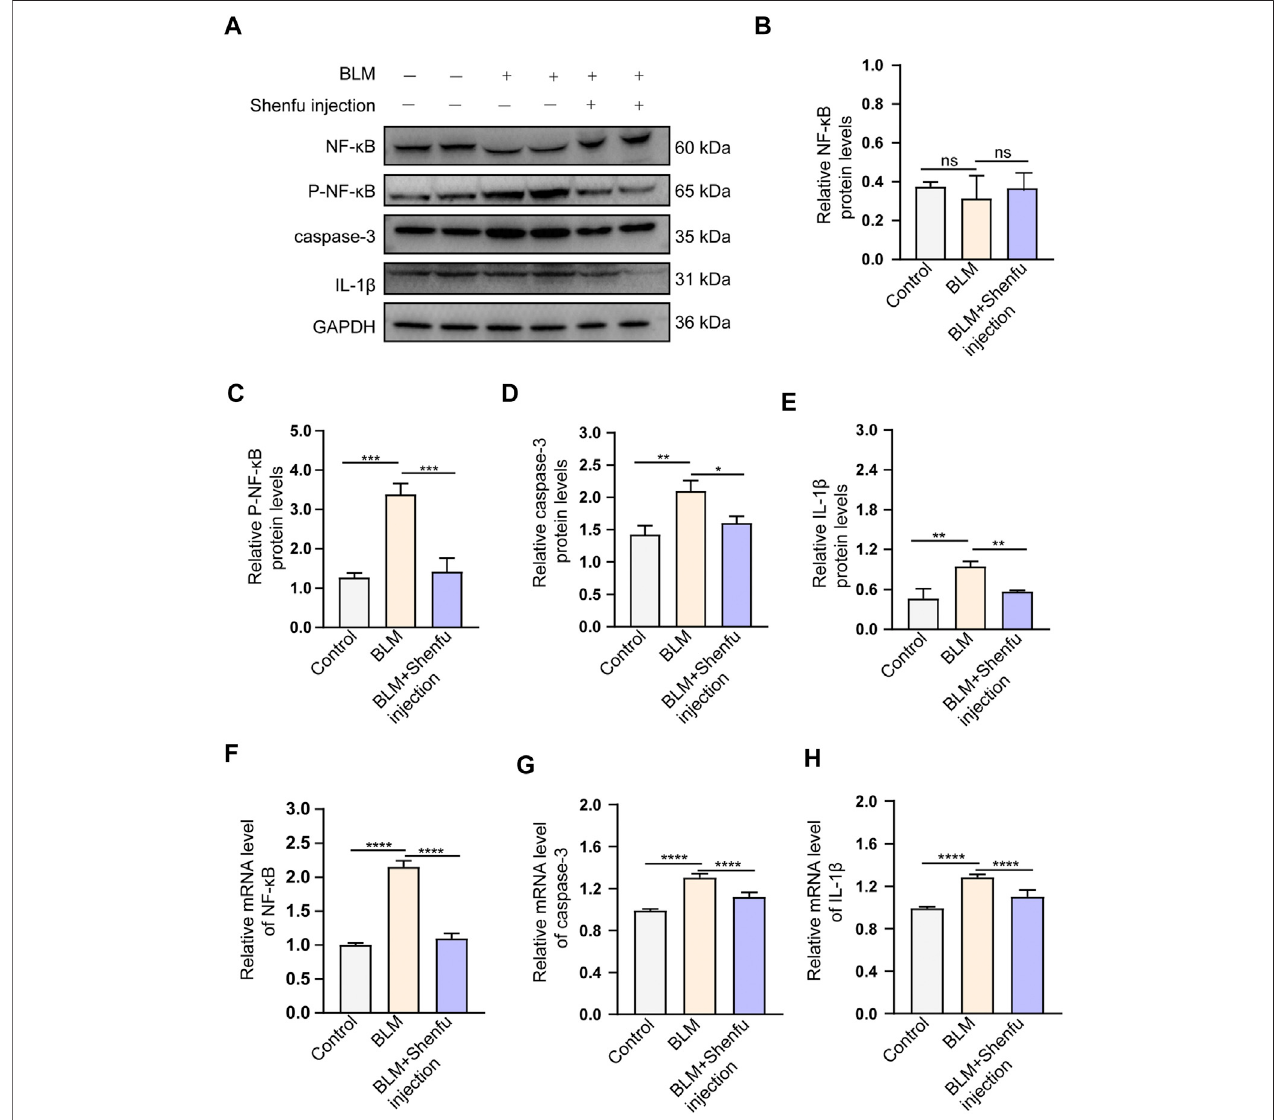
FIGURE 5 | Shenfu injection inhibits BLM-induced pulmonary fi brosis by targeting NFKBIA, CASP3 and IL-1B. (A) Western bot analysis of total NF- κ B, Phospho- NF- κ B,caspase-3andIL-1 β ineach group. (B – E) Quantitative analysisoftotalNF- κ B (B) ,Phospho-NF- κ B (C) ,caspase-3 (D) andIL-1 β (E) protein levelsineach group ( n (cid:1) 3micepergroup). (F – H) Quanti fi cationofrelativemRNAlevelsofNF- κ B (F) ,caspase-3 (G) andIL-1 β (H) ineachgroup( n (cid:1) 3micepergroup).Dataarepresentedas mean ± SD. **** p < 0.0001; *** p < 0.001; ** p < 0.01; * p < 0.05.